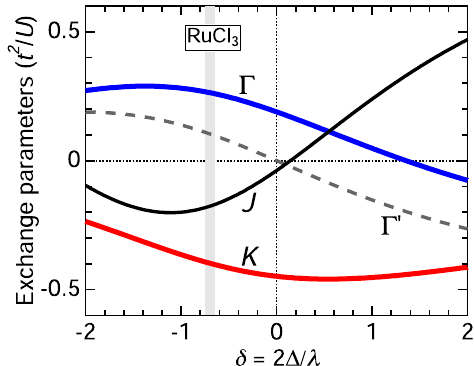
Fig. 6 Theoretical exchange parameters. Exchange parameters K (red), J (black), Γ (blue), and Γ 0 (gray) as a function of δ = 2 Δ / λ , calculated using 10 Dq = 2.4 eV, J H = 0.34 eV, and the pd charge-transfer gap Δ pd = 5.5 eV as obtained from the RIXS data (Fig. 2). We use representative values of the Coulomb interaction U = 2.5 eV for the Ru- d orbitals, U p = 1.5 eV and Hund ’ s coupling J p = 0.7 eV for the Cl- p orbitals, a ratio of t pd σ / t pd π = 2 between the pd charge-transfer integrals in the σ and π channels, and a direct t 2 g hopping t 0 ¼ 0 : 4 t . The exchange constants are given in units of t 2 / U . The vertical gray line indicates δ ~ − 0.7 appropriate for RuCl 3